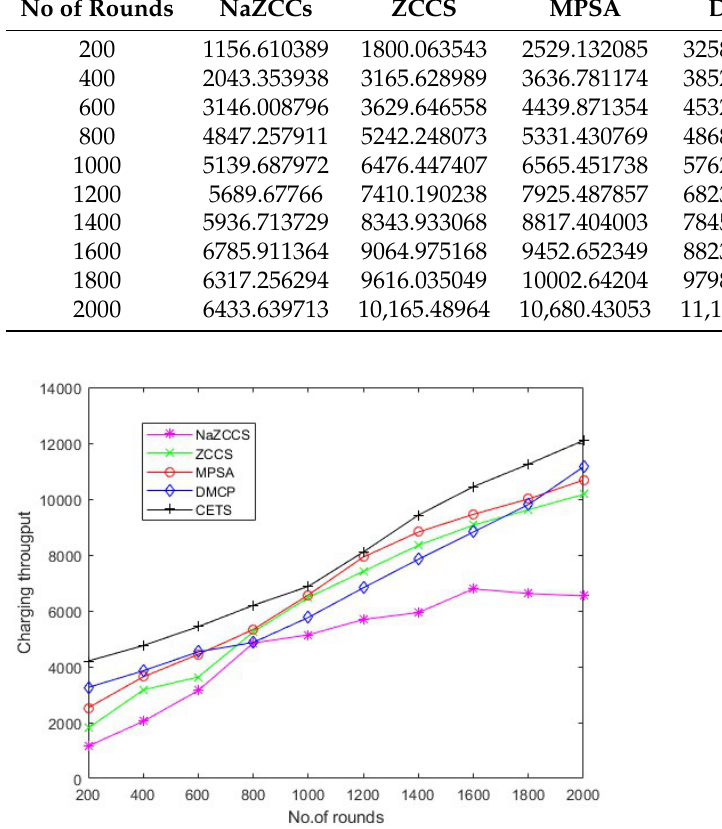
Figure 13. CETS versus other models on charging throughput per round at hop density